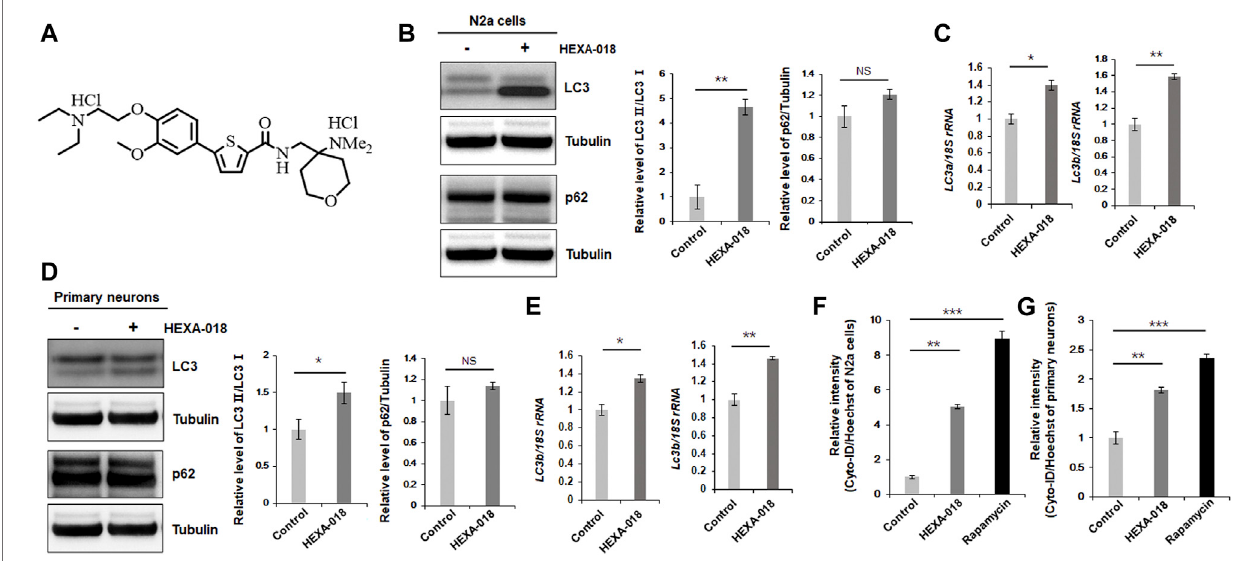
FIGURE1| HEXA-018 induces autophagyinneuronalcells. (A) Chemical structure ofHEXA-018. (B,C) N2a cellswere treatedwith HEXA-018 (5 µM)for24 h. (B) WesternblotanalysiswasperformedtodeterminetheamountofLC3-I/IIorp62protein.HEXA-018 signi fi cantlyincreasedtheLC3-IIlevelsinN2acellsbutdidnotaffect total p62 protein levels. Quanti fi cation of the immunoblots wasperformed from 3 independent experiments. ** p < 0.005; n. s. , not signi fi cant (unpaired Student ’ s t -test). (C) RT-PCR for lc3a and lc3b mRNA expression in HEXA-018-treated N2a cells. The quanti fi cation of lc3a and lc3b mRNA transcript levels is presented as the mean ± SEMfrom3independentreal-timeRT-PCRexperiments. 18SrRNA wasusedfornormalization.* p < 0.05;** p < 0.005(unpaired Student ’ s t -test). (D,E) Primary neurons were treated with HEXA-018 (0.5 µM) for 24 h. (D) Western blot analysis was performed to determine LC3-I/II or p62 protein expression. Quanti fi cation of the immunoblots was performed from 3 independent experiments. * p < 0.05; n. s., not signi fi cant (unpaired Student ’ s t -test). (E) RT-PCR for lc3a and lc3b mRNA expression in HEXA-018-treated primary neurons. The quanti fi cation of lc3a and lc3b mRNA transcription levels are presented as the mean ± SEM from 3 independent real-time RT-PCR experiments. 18S rRNA was used for normalization. * p < 0.05; ** p < 0.005 (unpaired Student ’ s t -test). (F,G) N2a cells (F) and primary neurons (G) were treated with HEXA-018 (5 µM/0.5 µM) for 24 h. Rapamycin (200 nM) was used as a positive control. Cyto-ID fl uorescence analysis was performed thereafter. The level of Cyto-ID fl uorescence was signi fi cantly increased in the HEXA-018-treated cells, which indicates autophagic activation. The fl uorescence signal intensity of Cyto- ID was normalized to that of Hoechst 33342. Data are presented as the mean ± SD from 3 independent experiments. ** p < 0.005; *** p < 0.001 (one-way ANOVA with Tukey ’ s multiple comparison